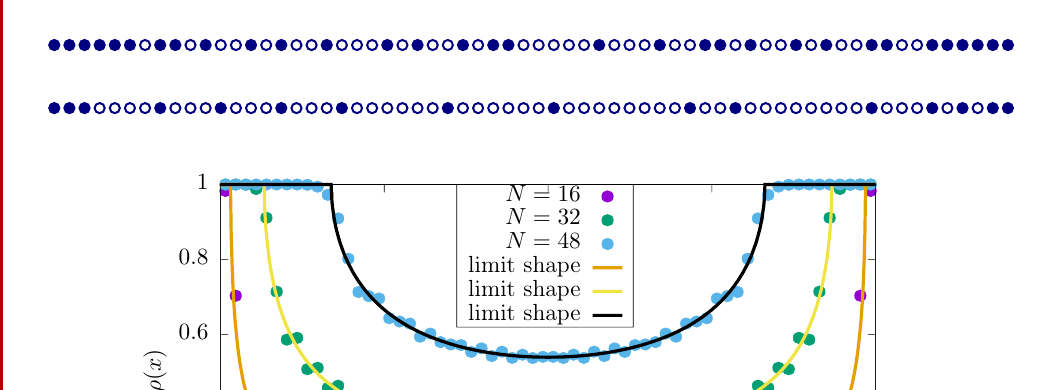
Figure 5: Limit shapes for the discrete model